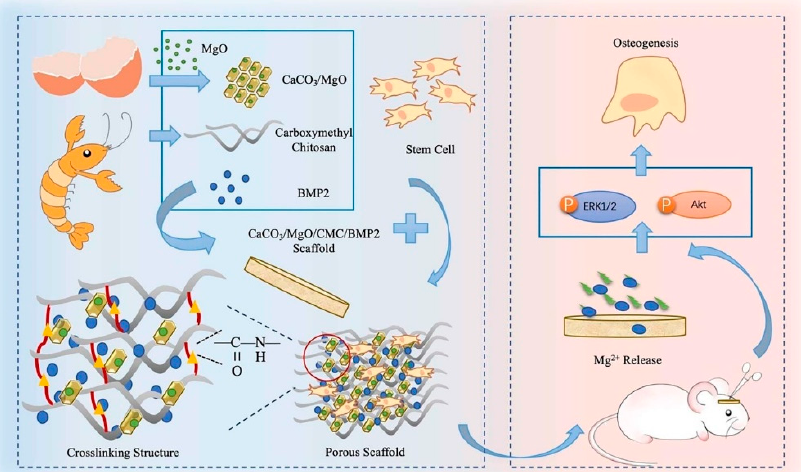
Figure 8. Scheme of the preparation of calcium carbonate/magnesium oxide/carboxymethyl chi- tosan/bone morphogenetic protein 2 (CaCO 3 /MgO/CMC/BMP2) scaffolds and their applications in vivo. Eggshell micropowder nanoparticles modified using MgO (CaCO 3 /MgO) were prepared in situ and then mixed with bone morphogenetic protein 2 (BMP2) and carboxymethyl chitosan (CMC). A porous scaffold was prepared via chemical crosslinking. The osteoinductivity of this scaffold was characterized at the molecular, cellular, and animal levels. The osteogenic mechanism of the prepared scaffold was related to the release of Mg 2+ and BMP2, and it could significantly promote seed cell osteogenic differentiation through the ERK1/2 and Akt pathways. Adapted from [193], Elsevier, 2020.